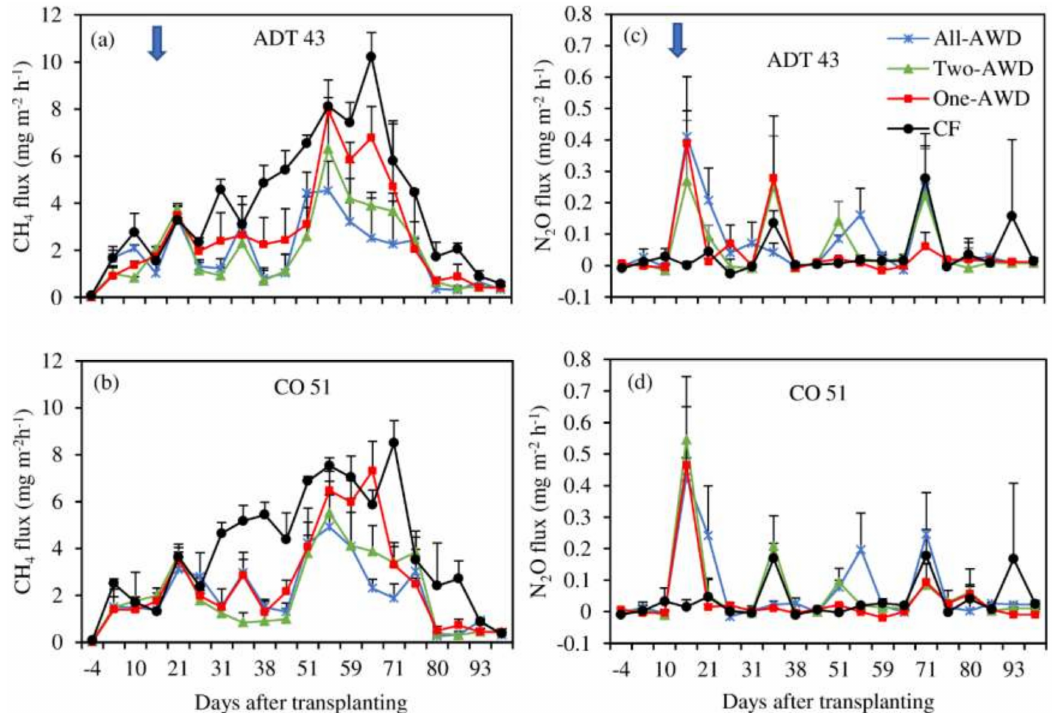
Figure 3. Variation in CH 4 ( a , b ) and N 2 O ( c , d ) fluxes during dry season rice for different water management practices. Error bars indicate standard error of means ( n = 3). Arrow—start AWD irrigation. Full-AWD—wetting and drying cycles throughout the growing season, Two-AWD—two early drying periods, One-AWD—one early drying period, CF—continuous flooding.